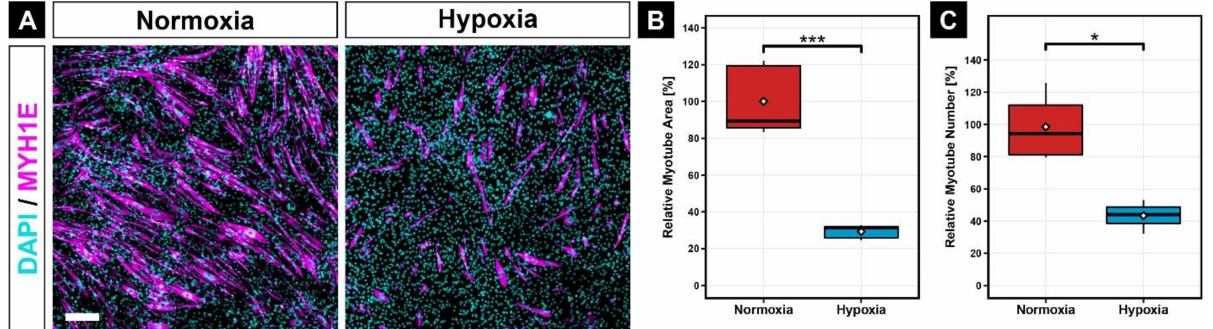
Figure 2. Immunocytochemistry against MYH1E (magenta) after 7 days of myogenic differentiation at 2% O 2 showed a great reduction of myotube formation compared to 21% O 2 ( A ). Quantification of relative myotube area ( B ) and relative myotube number ( C ) revealed significantly lower values in hypoxia than in normoxia. Scale bar: 200 µ m. Box plots represent the median, quartiles, range and mean (white diamond). Significance levels: * equals p ≤ 0.05; *** equals p ≤